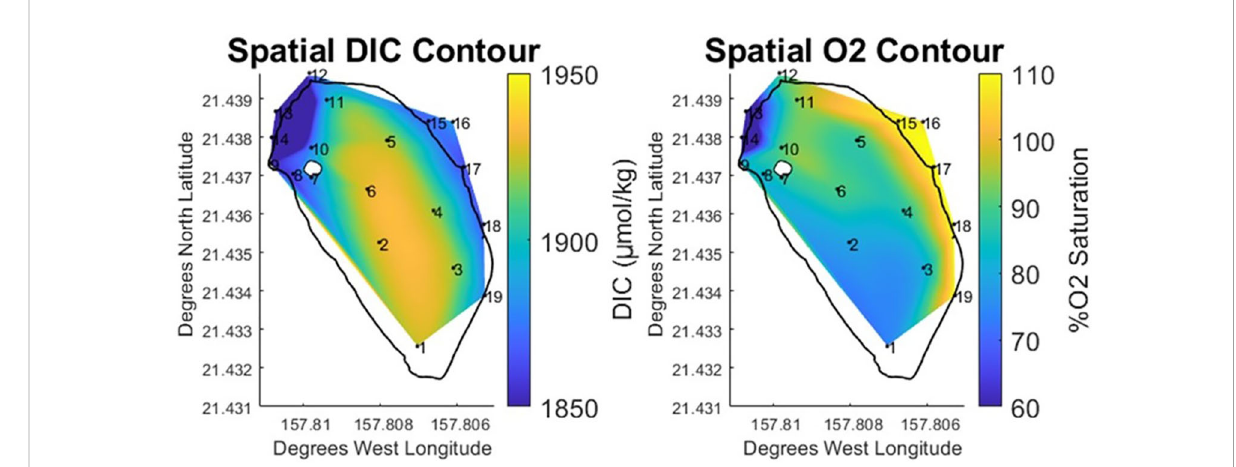
FIGURE 5 Vertically and temporally averaged contours of horizontal variability in % Oxygen Saturation and DIC at He ‘ eia Fishpond during the study period. Stations IDs (numbered in black) are plotted on contour to show sampling